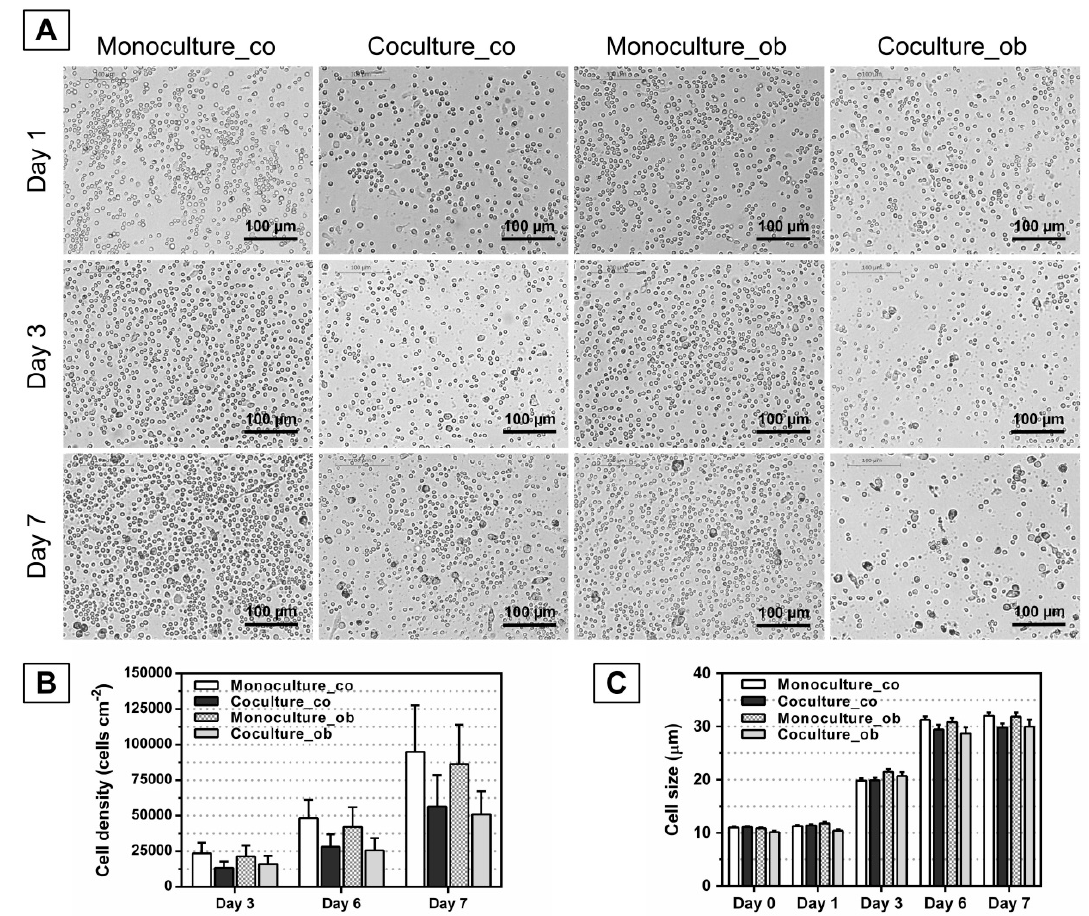
Figure 3. Morphology, cell numbers, and sizes of peripheral blood mononuclear cells (PBMCs) during DC differentiation in monocultures or co-cultures with untreated (co) and osteogenically induced JPCs for 7 days (ob). Microscopic images of PBMCs during DC differentiation on day 1, day 3, and 7 are shown ( part A ). Resulting cell numbers (cells/cm 2 , part B ) and determination of cell sizes ( µ m, part C ) in mono- and co-cultures were quantified using the ImageJ software. Results were averaged from 6 independent experiments. Scale bar, 100 µ m.